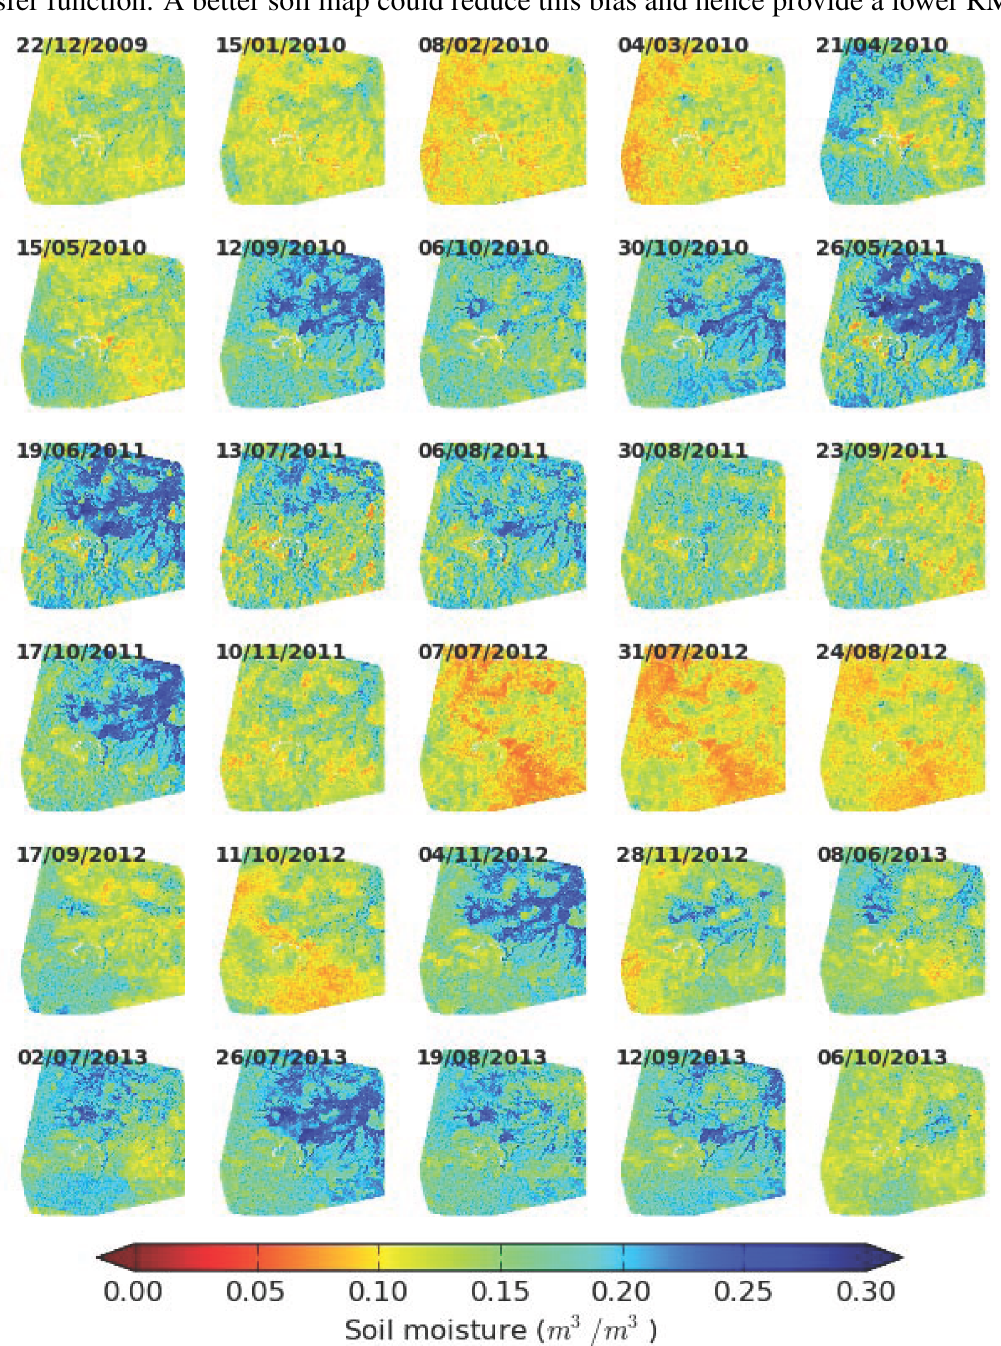
Figure 7. The soil moisture for the 30 RADARSAT-2